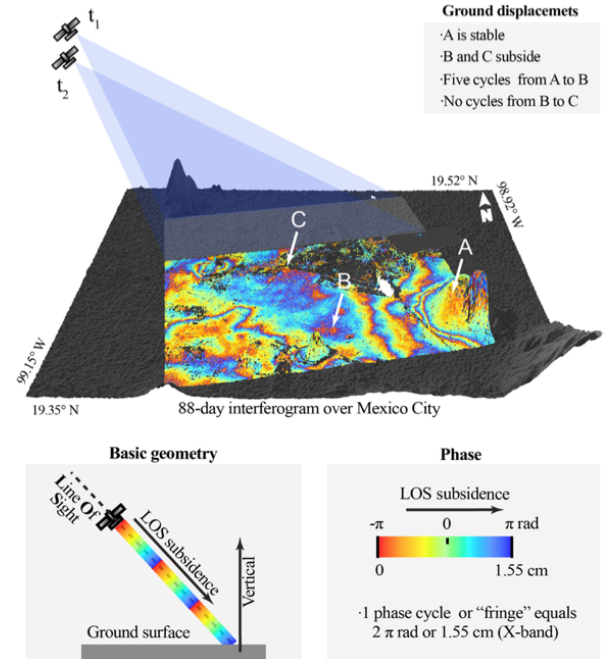
Figure 1. Schematic illustration describing the concept of repeat- pass InSAR. The interferogram was calculated from a COSMO- SkyMed SAR pair acquired on 3 April and 30 June 2012 over Mex- ico City. Point A is a stable area known as Chimalhuache hill. Point B is located close to Peñón de los Baños. Point C is located over Benito Juárez International Airport. Shaded relief from SRTM